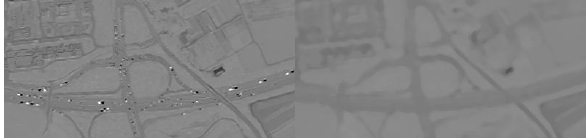
Figure 15: Sample processing of bands, step 1, example WorldView-2, left: difference image of red and yellow band, right: median filtered difference